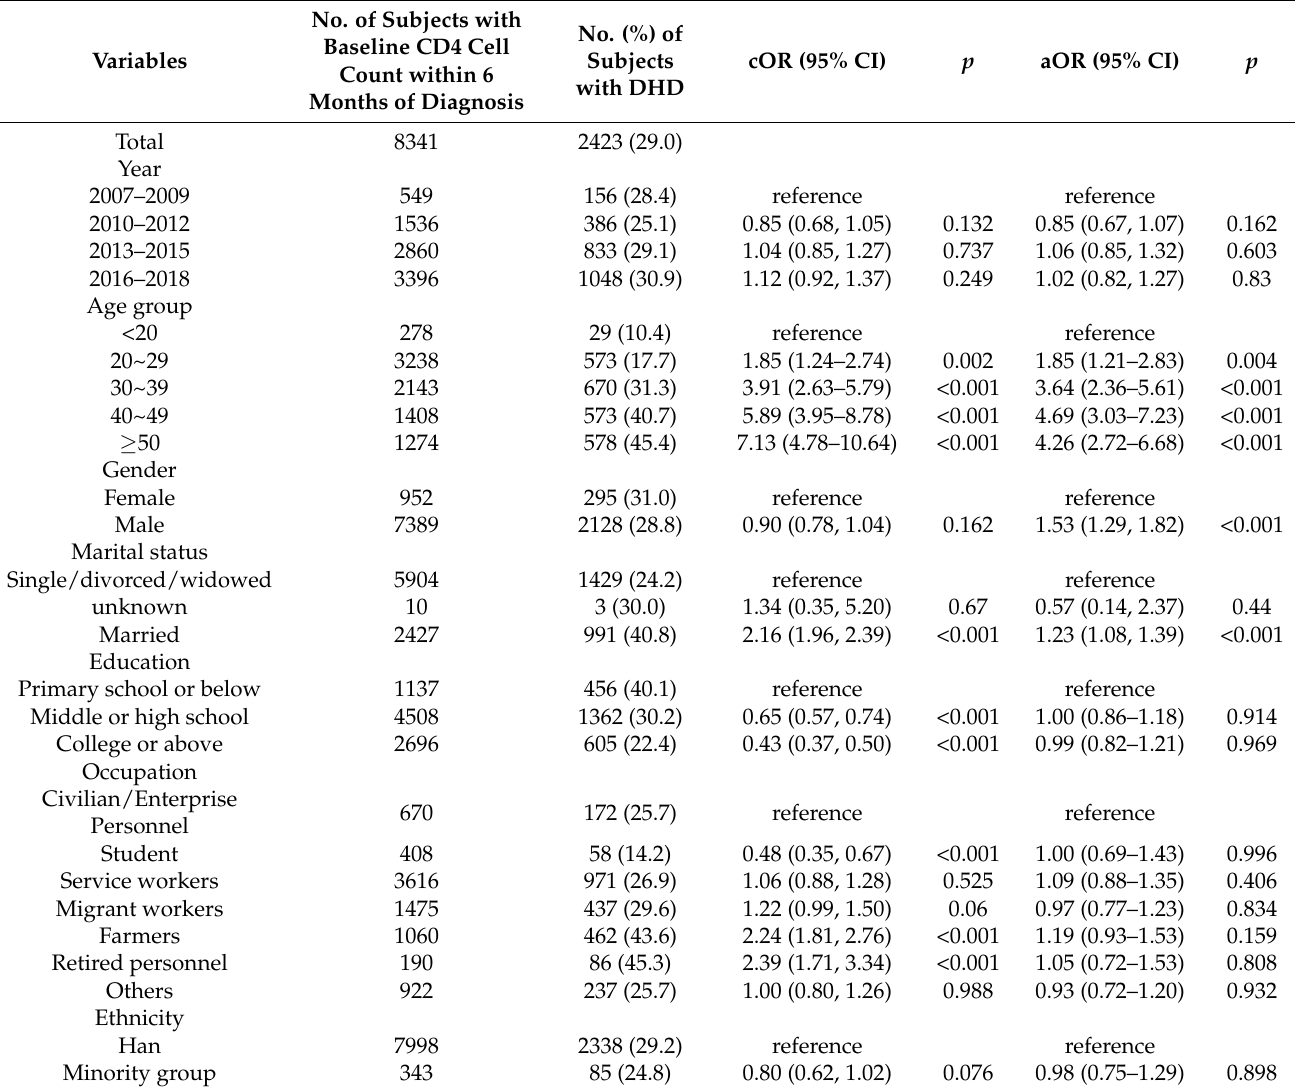
Figure 3. Trends of DHD among HIV newly diagnosed cases in Hangzhou, 2007–2018. Table 3. Factors associated with DHD, based on multivariate logistic regression analysis.